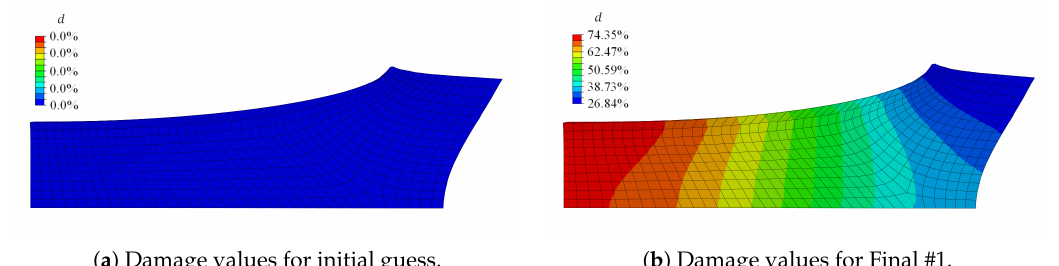
Figure 8. Comparison of the contour plot of the damage value d at the final load step for ( a ) the initial parameter set and ( b ) the optimised Parameter Set #1.